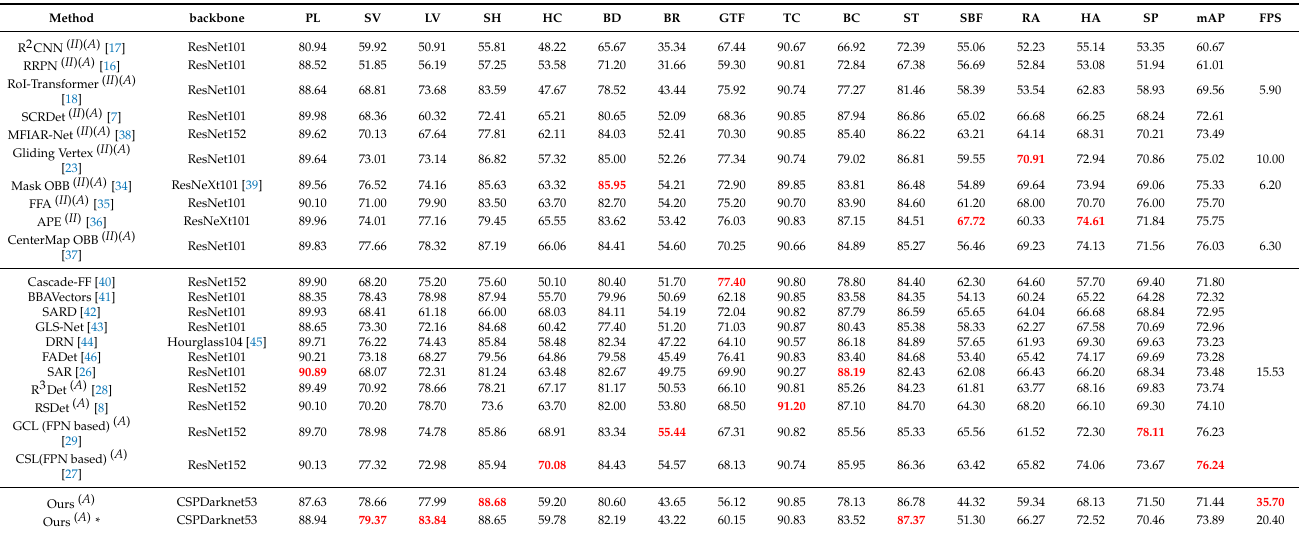
Table 2. The comparison results on the DOTA1.0 dataset.